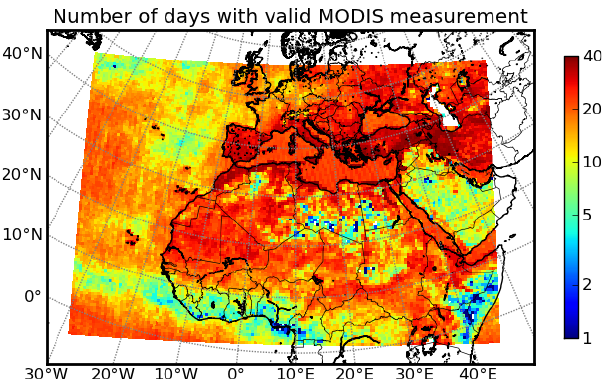
Figure 5. Number of days with available MODIS measurements between 6 June and 15